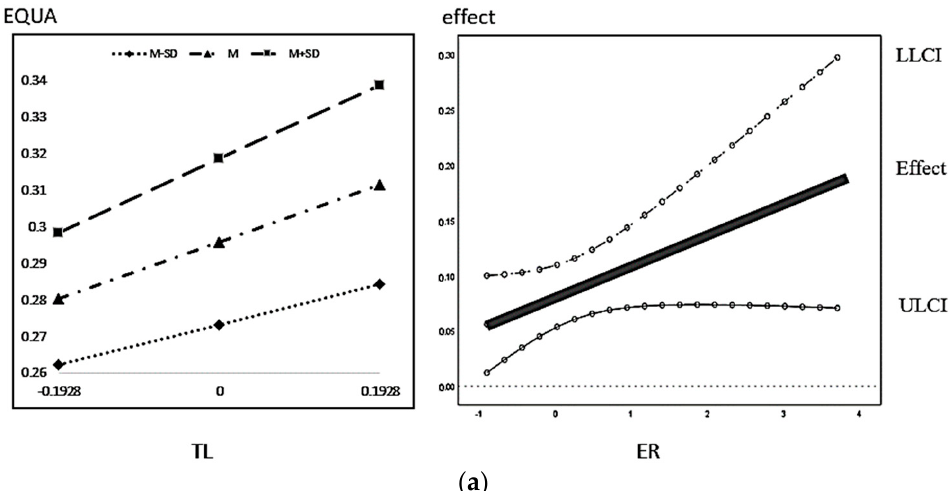
Figure 5. ( a ). Impact of green finance on the rationalization of industrial structure under the role of environmental regulation. ( b ) Impact of green finance on the advanced industrial structure under the role of environmental regulation.